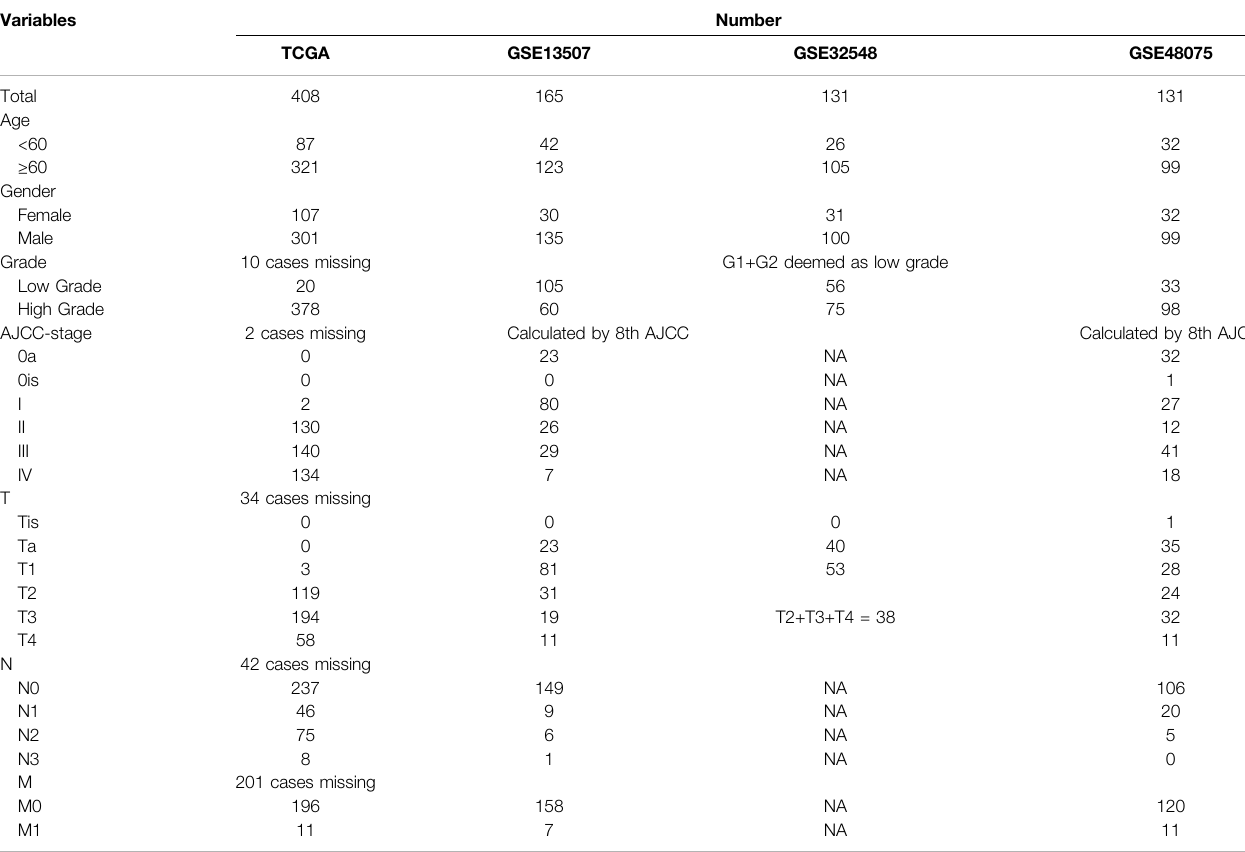
TABLE 1 | Baseline clinical characteristics of four